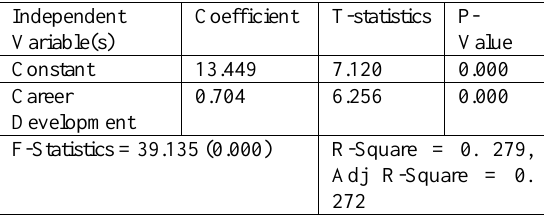
Figure 2. Job Status of the Respondents